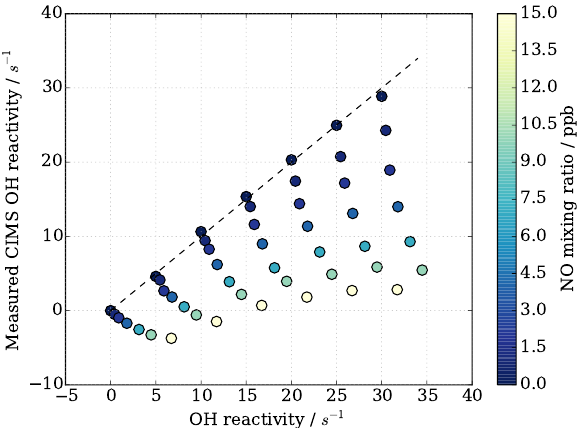
Figure 8. CIMS OH reactivity underestimation as result of NO − HO x recycling interference in external flow tube NO correc- tion experiment. OH reactivity is the average of experiments with OH reactants propane, isoprene, ethene and